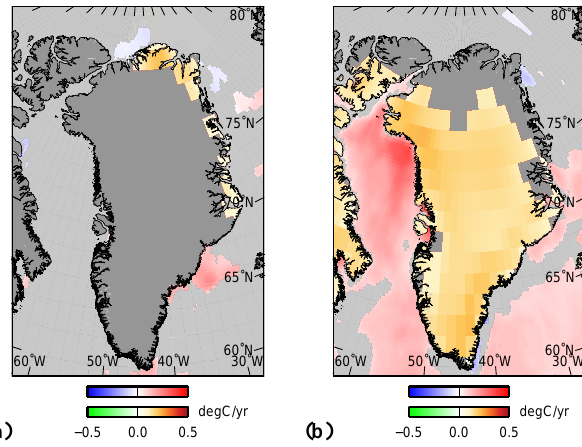
Fig. 3. Linear trend in temperature over the periods (a) 1982 to 1995 and (b) 1995 to 2010, where significant at the 95% level. Over land: ERA-Interim summer (June–August) mean 2m air temperatures. Over ocean: OISST summer (July–September) sea surface tempera- tures. The upper colour bars apply to the SSTs and the lower colour bars to the air temperatures. Grey pixels are where the difference was not significant at the 95%